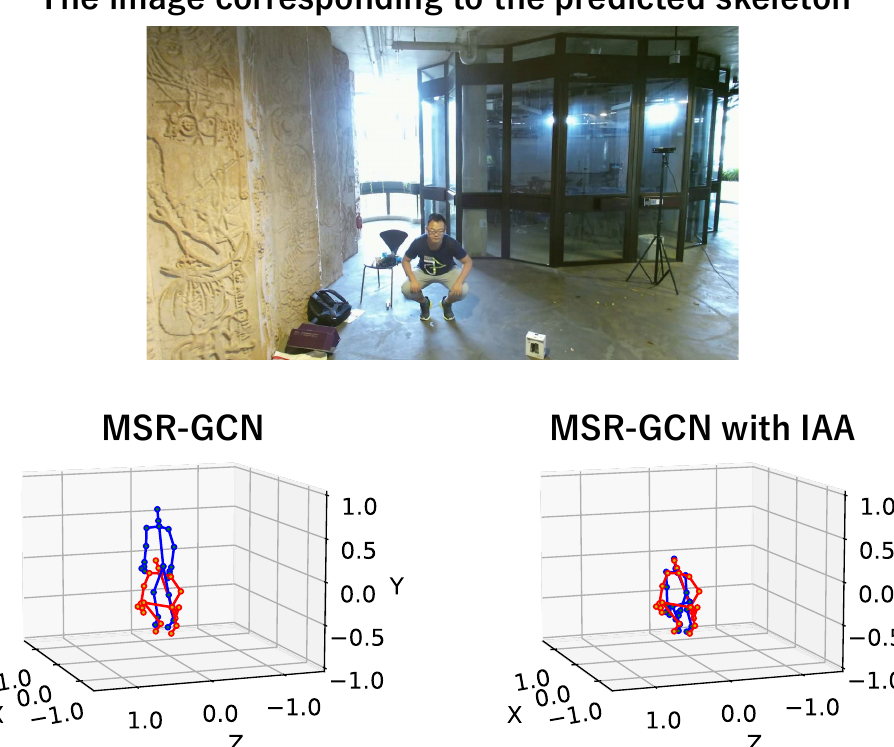
Figure 10. A prediction example of the 30th frame of prediction (blue) and ground truth (red) in “squat down”. In non-object-related motions, the future skeleton is also well predicted by our proposed